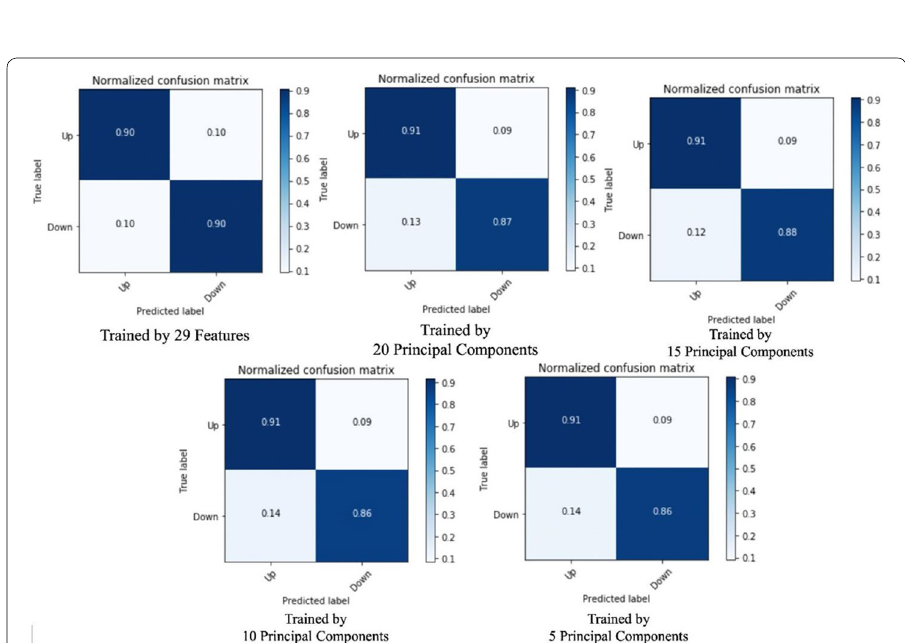
Fig. 7 How does the number of principal components affect evaluation